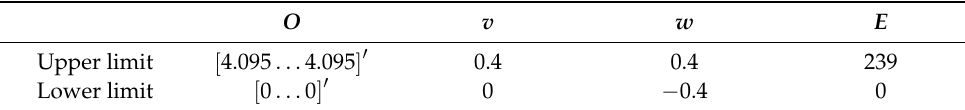
Table 2. The value limits for the reward parameters.